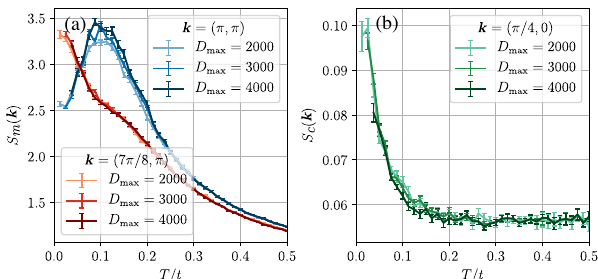
FIG. 3. Magnetic and charge structure factors at the ordering vectors of the 32 × 4 square cylinder at U=t ¼ 10 for p ¼ 1 = 16 . 2000 , 3000, We compare results from METTS with D max ¼ 4000. (a) Magnetic structure factor S m ð k Þ . The antiferromagnetic ordering vector k ¼ ð π ; π Þ is shown in blue. The ordering vector of the half-filled stripes k ¼ ð 7 π = 8 ; π Þ is shown in red. (b) Charge structure factor S c ð k Þ at stripe ordering vector k ¼ ð π = 4 ; 0 Þ . A transition from stripe order to short-range antiferromagnetic order takes place at T=t ≈ 0 . 05 . We find agreement between simula- tions at different bond